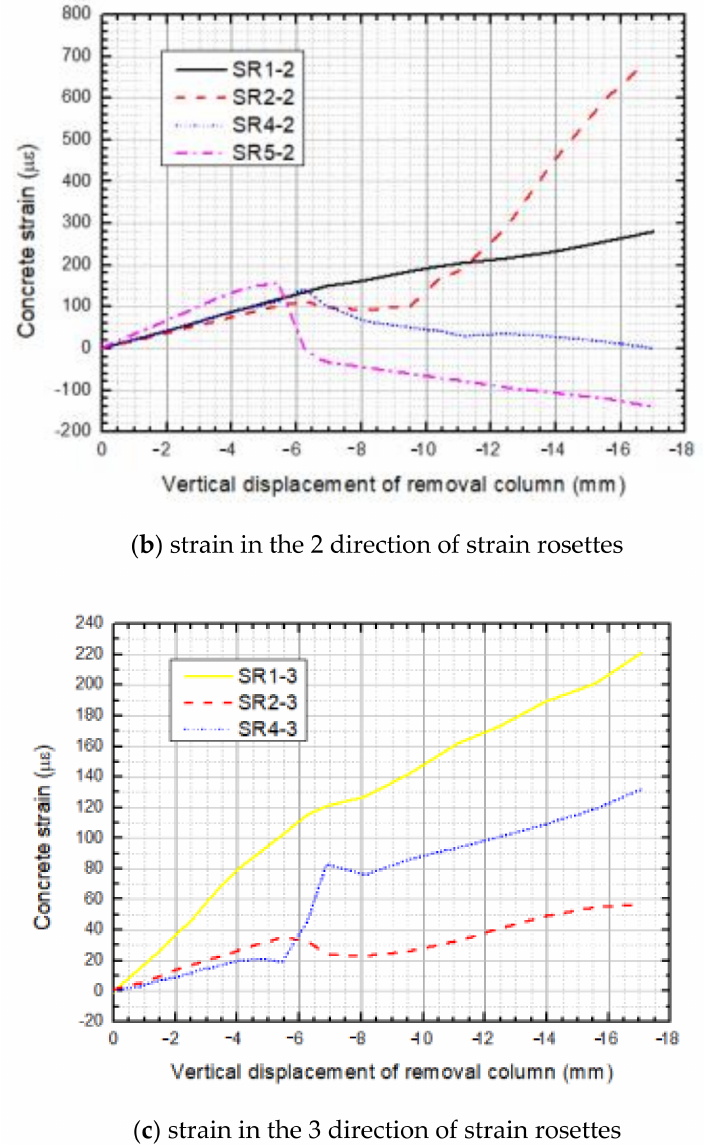
Figure 11. Concrete strain at top surface of P1. ( a ) strain in the 1 direction of strain rosettes; ( b ) strain in the 2 direction of strain rosettes; ( c ) strain in the 3 direction of strain